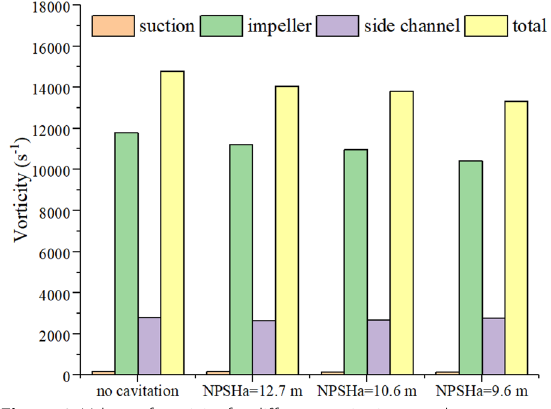
T ) for different cavitation =